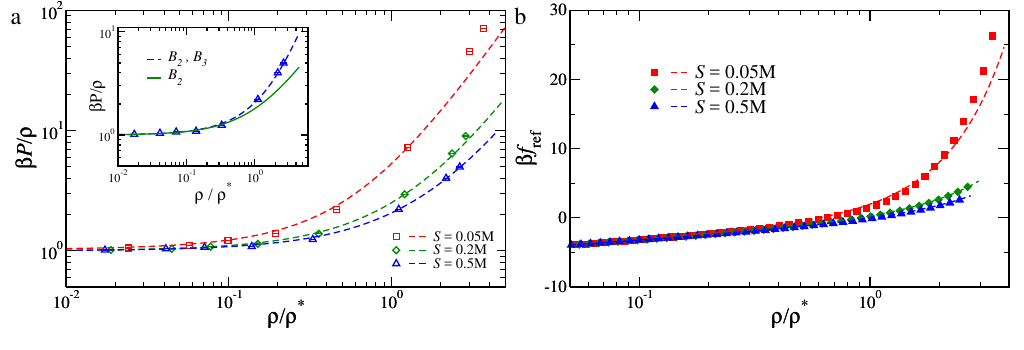
Figure 4. ( a ) Reduced pressure of a reference fluid of tetramers, as function of the reduced density ρ / ρ ∗ . Points are data from numerical simulations; dashed lines are polynomial fits (Equation (4)). Inset: Pressure as function of ρ / ρ ∗ for S = 0.5 M: symbols and dashed line as in the main panel; the full line is the second-order virial approximation; ( b ) Reference free energy as function of the reduced density ρ / ρ ∗ computed using thermodynamic integration (TI) (full symbols) and a third-order virial approximation (dashed lines).